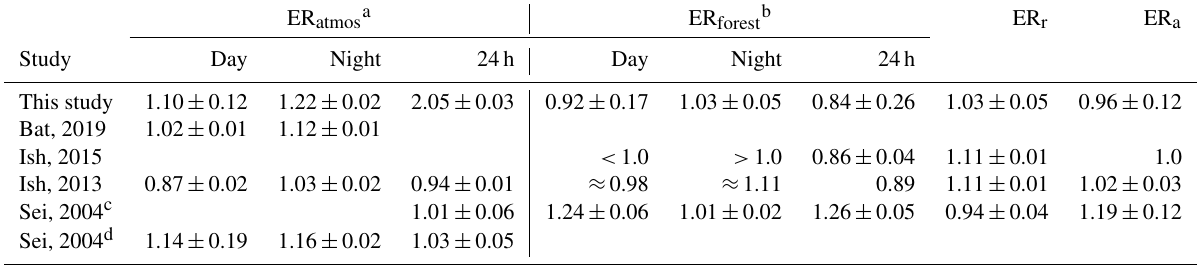
Table 4. The different exchange ratio (ER) signals of previous studies are given, with the ER of the atmosphere (ER atmos ), the ER of the forest (ER forest ), the ER of the respiration processes (ER r ), and the ER of the assimilation processes (ER a ). Bat, 2019 is short for Battle et al. (2019), Ish, 2015, represents Ishidoya et al. (2015), Ish, 2013, represents Ishidoya et al. (2013), and Sei, 2004, represents Seibt et al. (2004). ER atmosa ER forestb ER r ER a Study Day Night 24h Day Night 24h This study 1.10 ± 0.12 1.22 ± 0.02 2.05 ± 0.03 0.92 ± 0.17 1.03 ± 0.05 0.84 ± 0.26 0.96 ± 0.12 Bat, 2019 1.02 ± 0.01 1.12 ± 0.01 Ish, 2015 < 1.0 Ish, 2013 0.87 ± 0.02 Sei, 2004 c Sei, 2004 d 1.14 ± 0.19 1.16 ± 0.02 1.03 ±